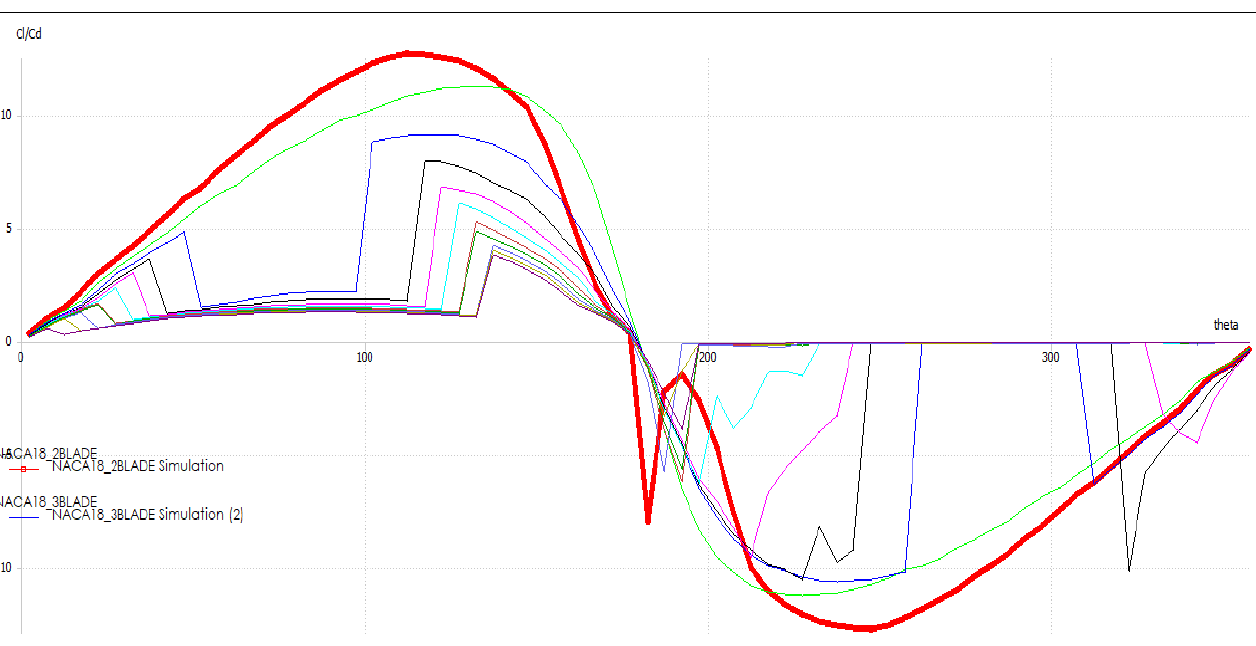
Figure 25. Cl/Cd vs theta plot of bottom-section for TSR 1